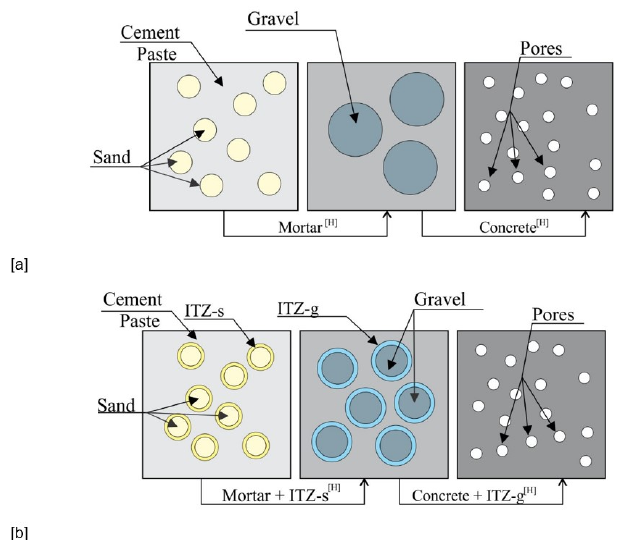
Figure 6: Three-level homogenization considering (without [a] /with [b]) interfacial transition zone and three- and multiple-phase models. Source: Author.